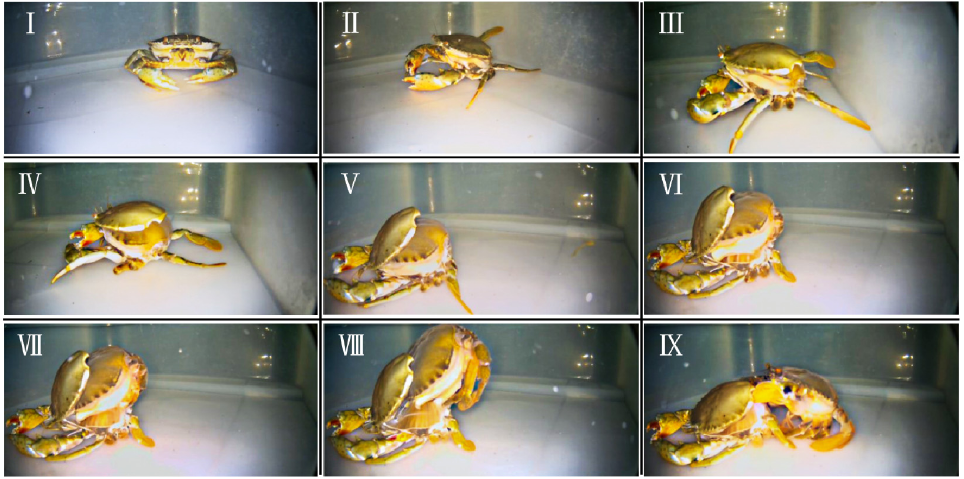
Figure 1. The production process of soft-shell crab (underwater view). ( I – II ) represent the process of premoult. ( III – IX ) represent the process of ecdysis.